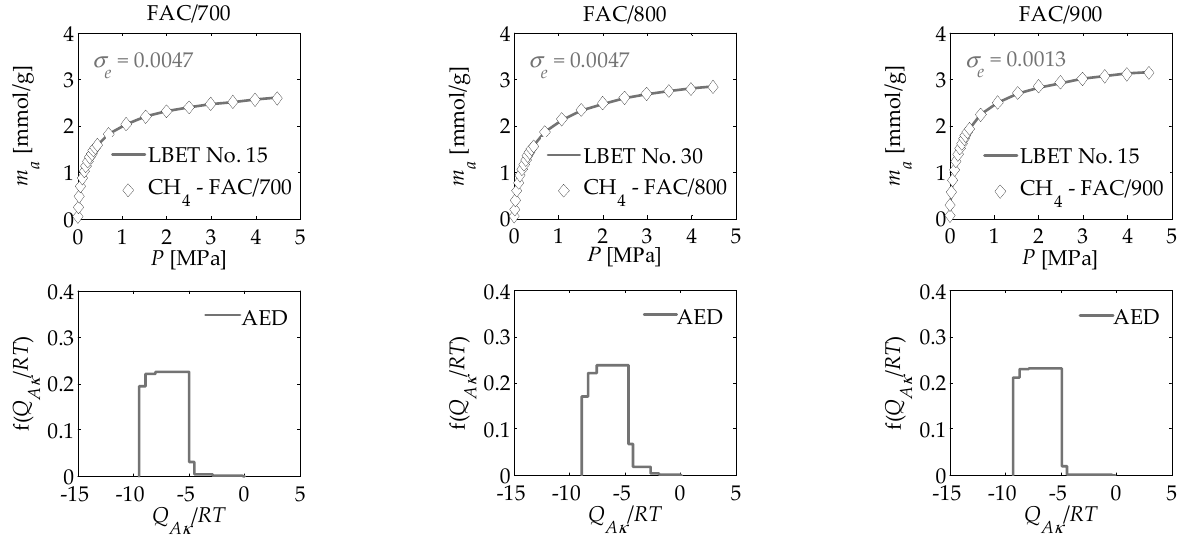
Figure 6. Methane adsorption isotherms for activated carbons derived from the leaves of common polypody and the